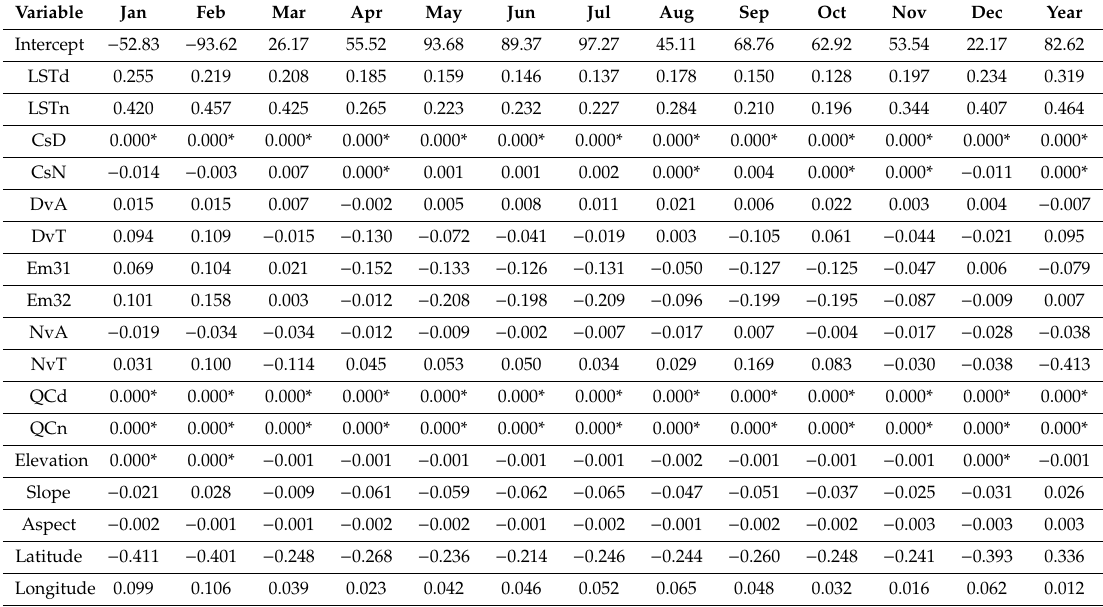
Table A1. Model coe ffi cients for the twelve-monthly PLS regression models including all 17 predictor variables. In the last column, the model of the annual average Ta is also included.